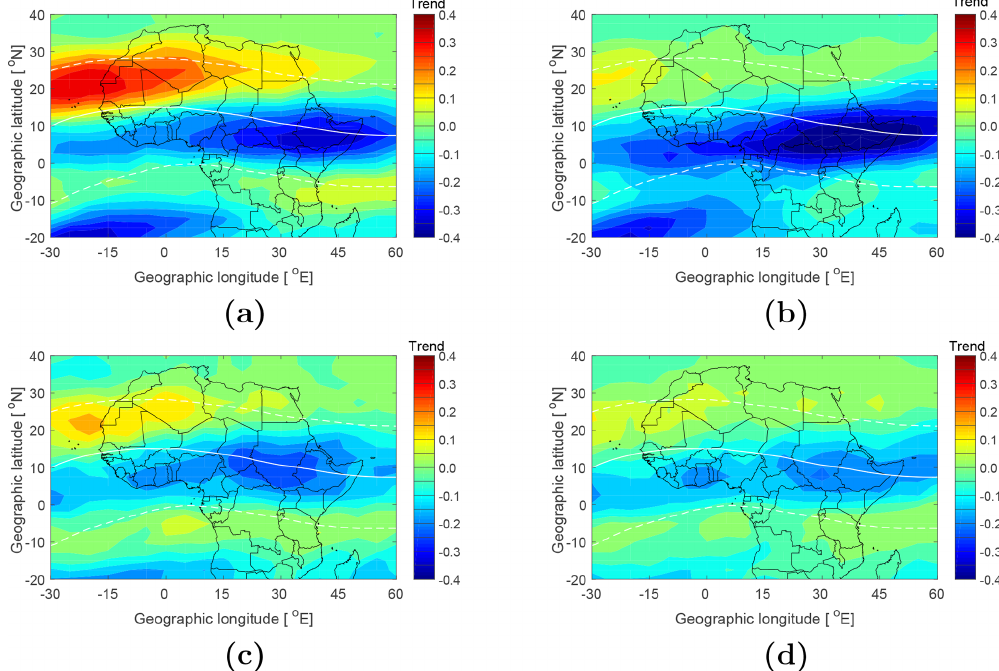
Figure 9. Trends in TEC over the African low-latitude region derived from CODE’s (a, b) and IGS (c, d) GIMs. Panels (a) and (c) are for the period 1999–2017 while (b) and (d) are for the period 2003–2017. The horizontal curved white lines are same as described in Fig.